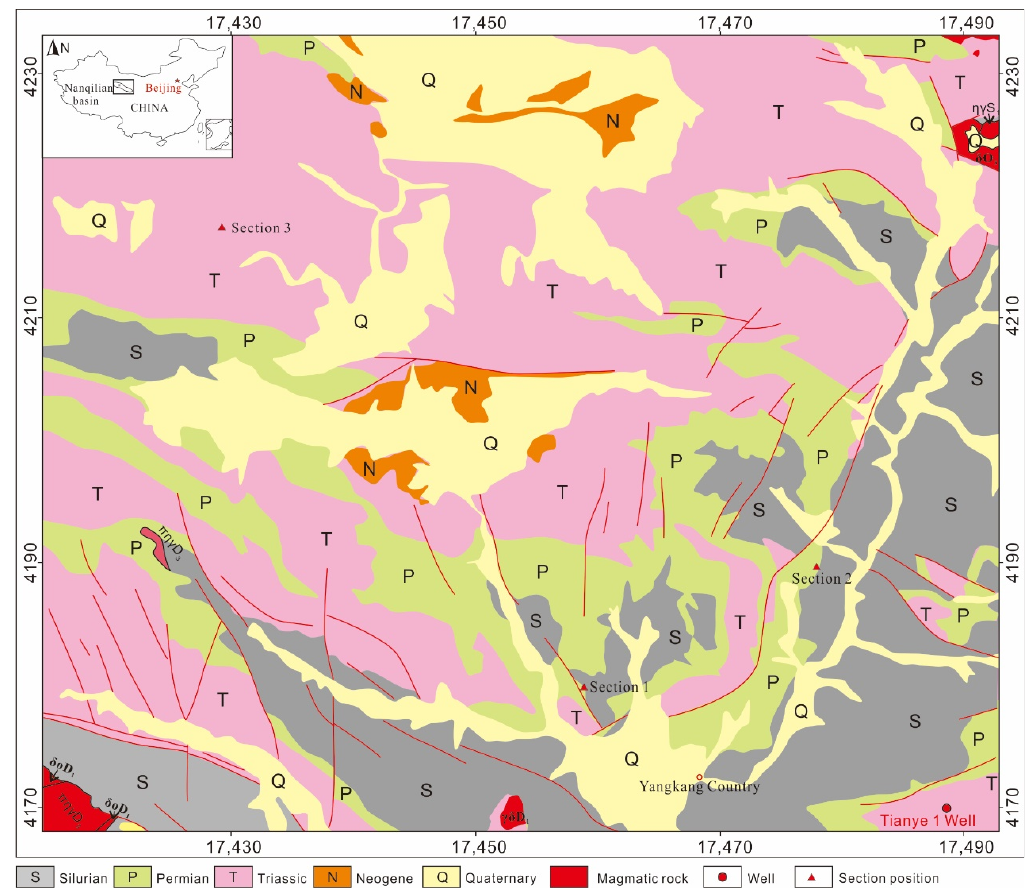
Figure 1. The regional structural characteristics of the study area.